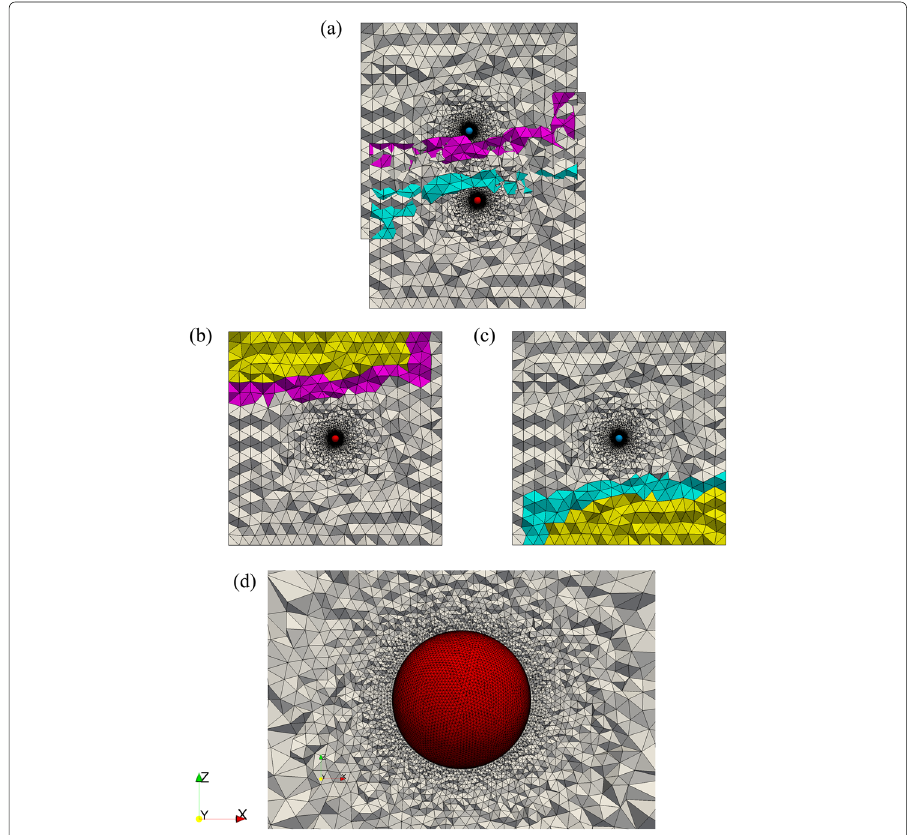
Fig. 10 Computational grids for the crossing